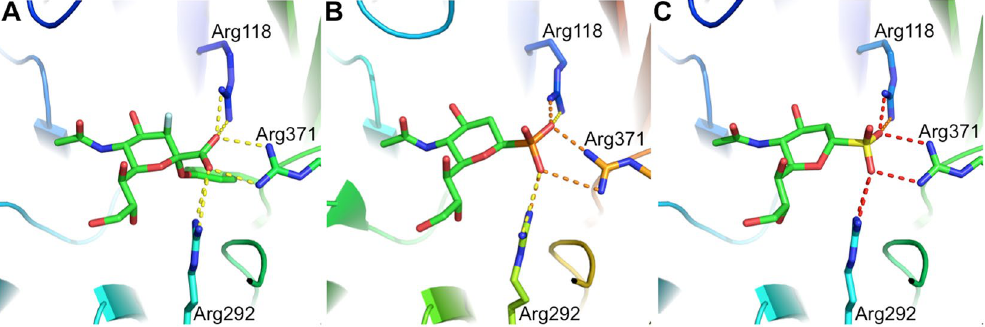
Figure 1. NA binding comparison of anomeric carboxy, anomeric phosphono and anomeric sulfo analogues of N -acetylneuraminic acid. ( A ) The carboxylate of 3-fluoro-Neu5Ac covalently bound to influenza A/ RI/5 + /1957(H2N2) NA (N2) NA (PDB ID: 45H2) 3 . ( B ) An equatorial phosphonate Neu5Ac analogue (eqPO 3 H) bound to influenza A/Tokyo/3/67(H2N2) NA with the phosphorus atom colored orange (PDB ID: 1INX) 6 . ( C ) Predicted binding of the equatorial sulfo-sialic acid analogue 7a to N2 with the sulfur atom colored yellow (based on PDB ID: 45H2). The structure of 7a was modeled in the N2 active site using Molecular Operating Environment (MOE). Electrostatic interactions with the anomeric functional groups are shown as dashed lines with stronger predicted ionic interactions colored orange and